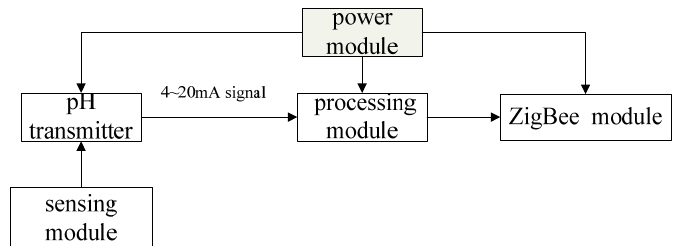
Figure 2. The system architecture of a data monitoring